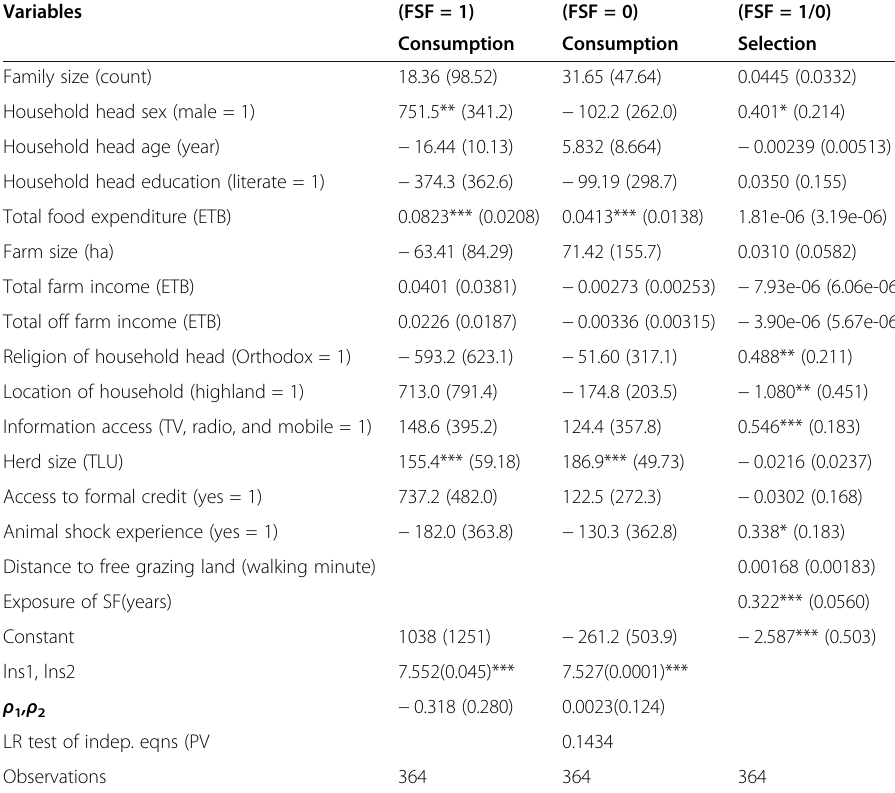
Table 3 Endogenous switching for FSF adoption and milk and meat consumption expenditure Variables (FSF =